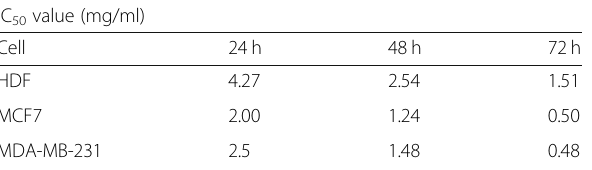
Table 2 IC50 values of HDF, MCF7 and MDA-MB-231 cells lines incubated with prunus armenica for 24, 48 and 72